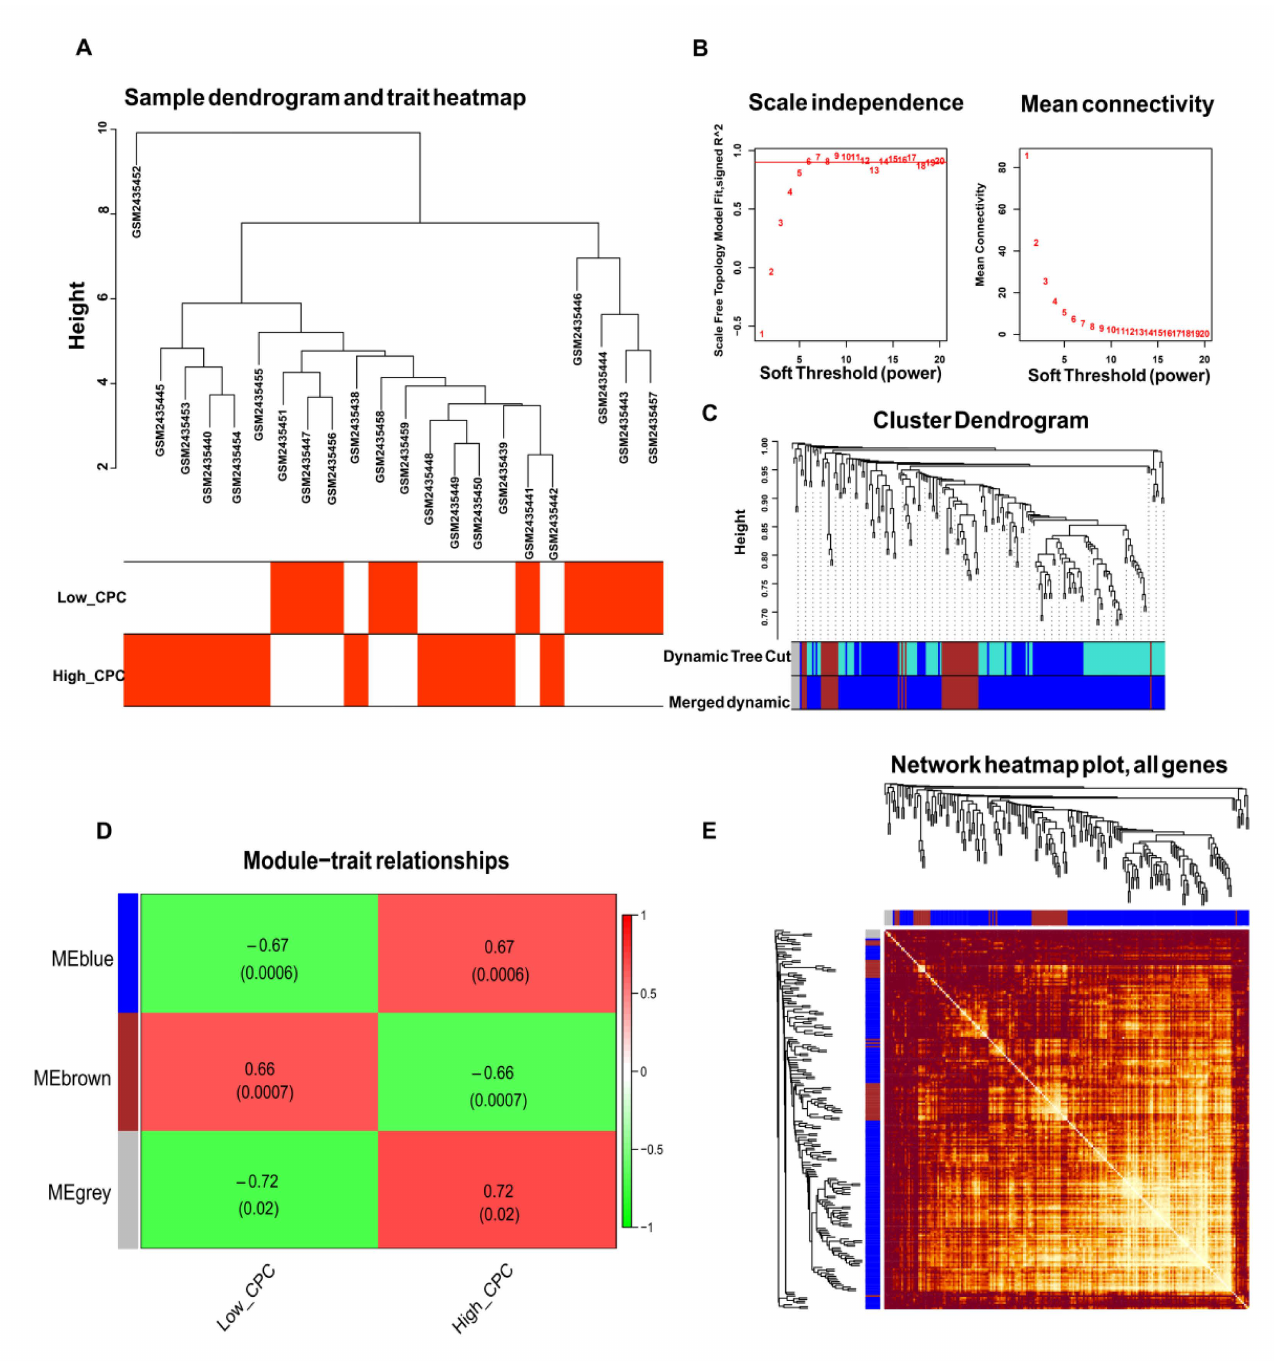
Figure 2. Weighted gene co-expression network analysis (WGCNA) and identification of the key modules via WGCNA. ( A ) The distribution of samples in GSE92696. ( B ) The screen of the best soft thresholds. Six was considered the best soft threshold. ( C ) The merging of similar modules. ( D ) Heatmap of the correlation between the module and the clinical characteristics of the patients in GSE92696. ( E ) The co-expression of DEGs in each